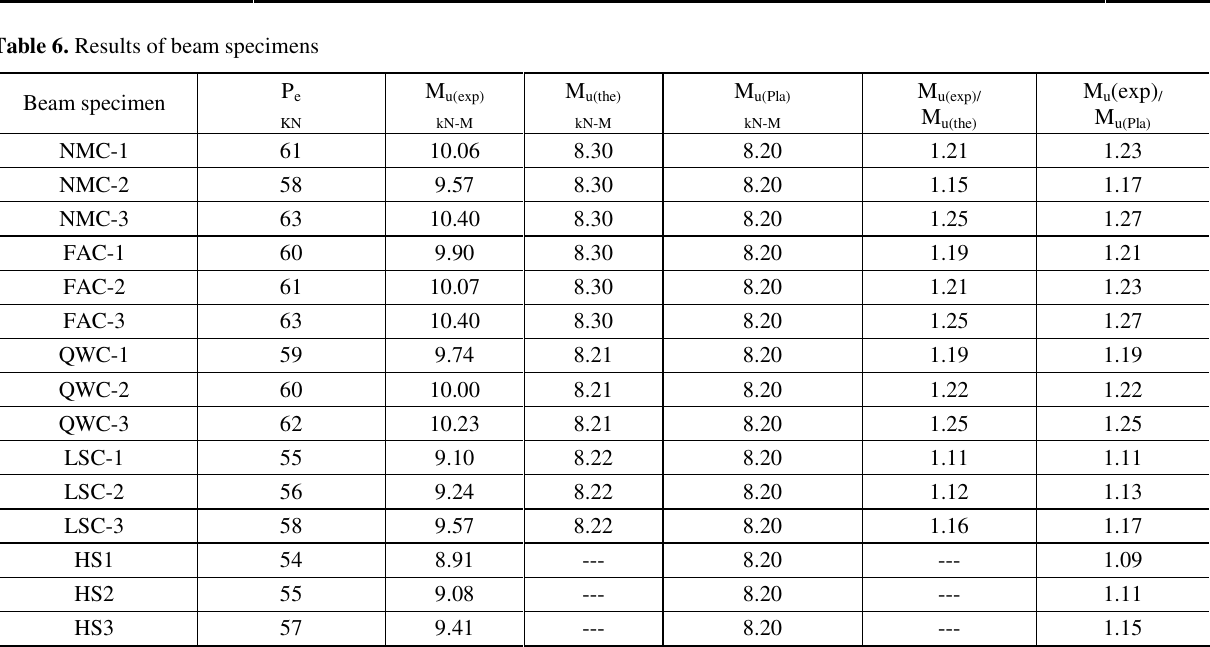
Table 5. Rotation angles at ultimate moment Size of hollow